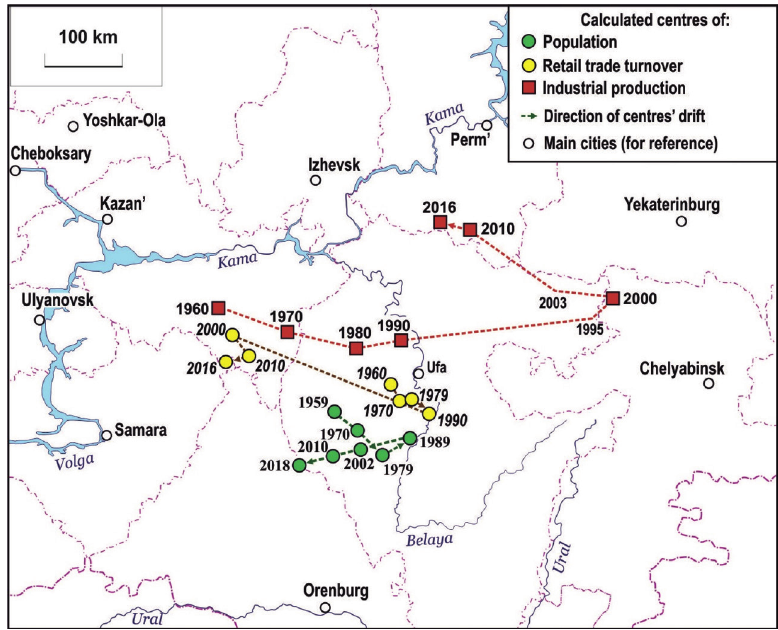
Figure 1. Centers of gravity (centroids) of population, retail trade turnover and industrial production of RSFSR — Russia within borders, prices and according to the accounting methodologies of the re- spective years. Calculated and compiled by the